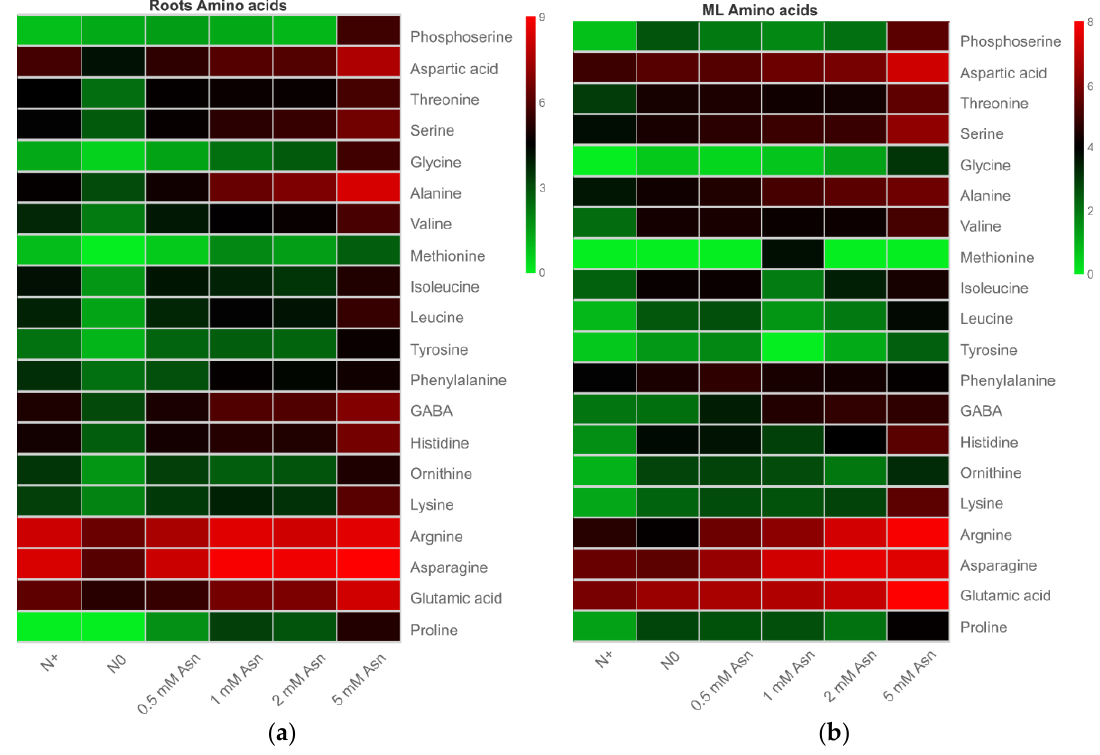
Figure 5. Heatmap illustration of the amino acid composition of poplar ‘Nanlin895’ roots ( a ) and mature leaves ( b ) under different asparagine (Asn) treatments. “N0” indicates N-free; “N+” represents inorganic N control. The concentration of Asn applied was 0.5 mM, 1 mM, 2 mM, and 5 mM as indicated. The color bar indicates low (green) expression levels to high (red).